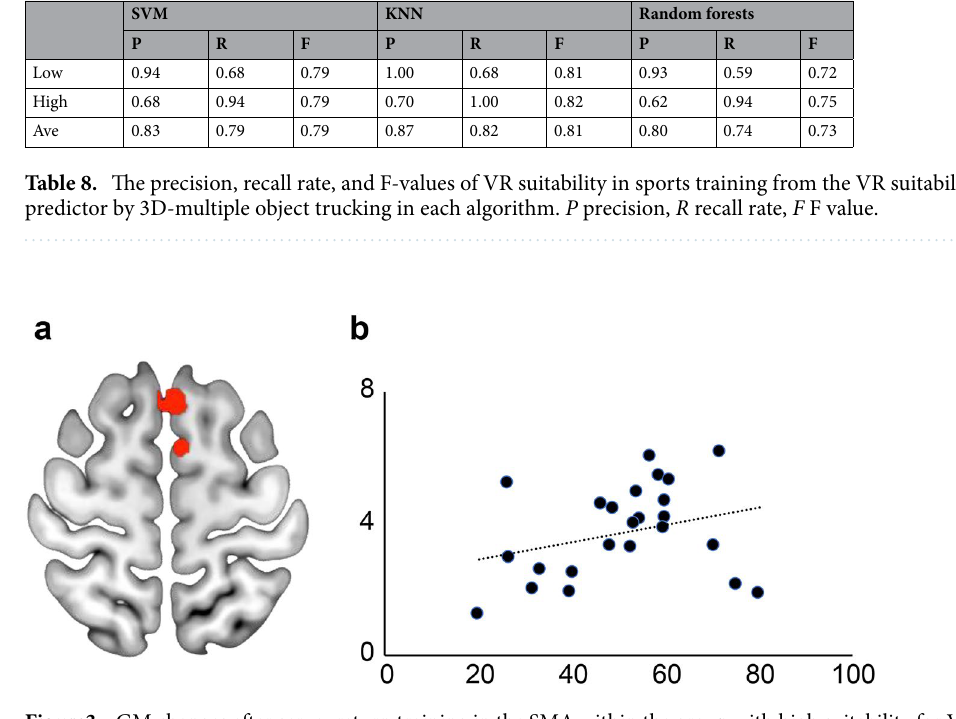
Figure3. GM changes after serve–return training in the SMA within the group with high suitability for VR. ( a ) Changes in GM in the SMA before and after serve–return training in the group with high suitability for VR ( b ) A correlation was found between the change rate in serve–return score and the change rate of